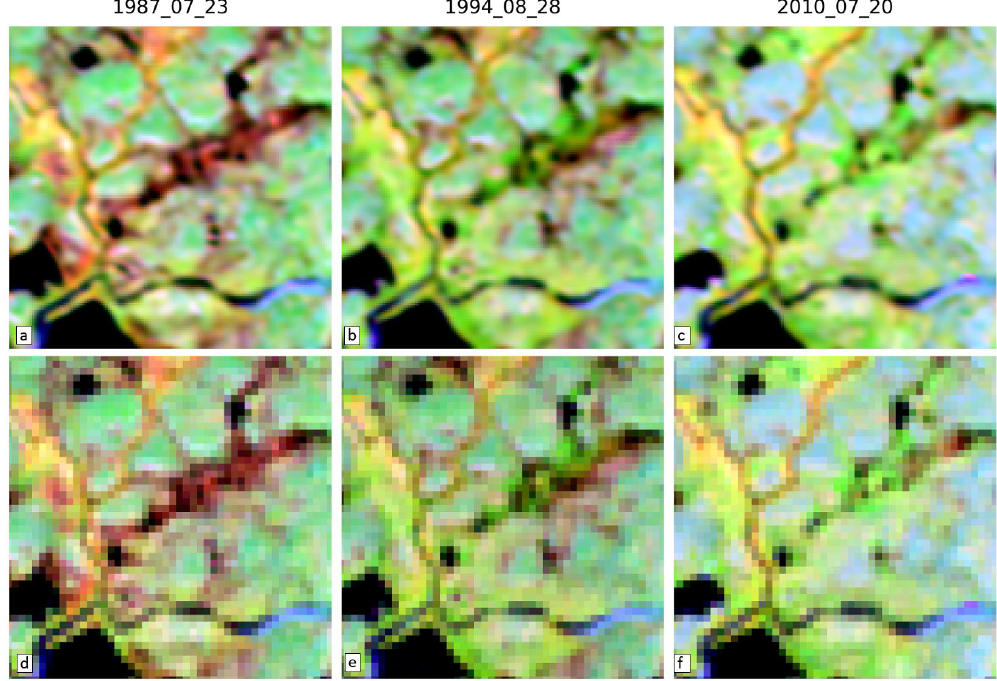
Figure 6. Example temporal extension result for a northern tundra area. ( a,b,c ) is the spatially enhanced result and ( d,e,f ) is the original Landsat.